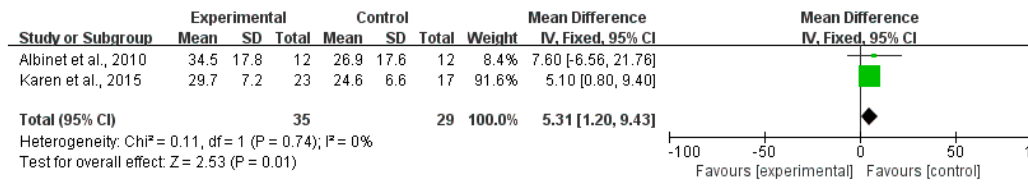
Figure 6. Forest plots of WMS scale outcomes in overall analysis [14,23,24].